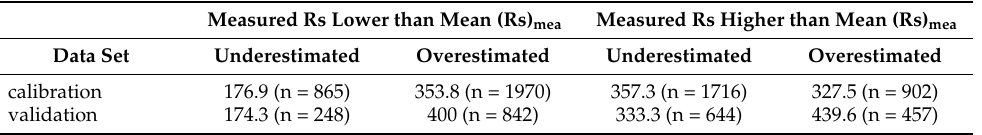
Table 11. RMSE values (J · cm − 2 · day − 1 ) and number of data points belonging to under- and over- estimation sets for measured solar radiation less or higher than mean (Rs) mea in calibration and validation phases using proposed model.